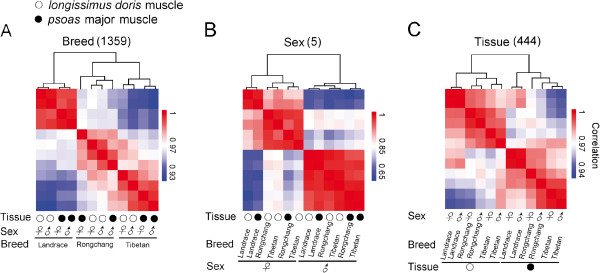
Heat map matrix of Spearman correlations among samples. (A) The counts of 1,359 DEGs among the three breeds. (B) The counts of five DEGs between the sexes. (C) The counts of 444 DEGs between the two tissues.